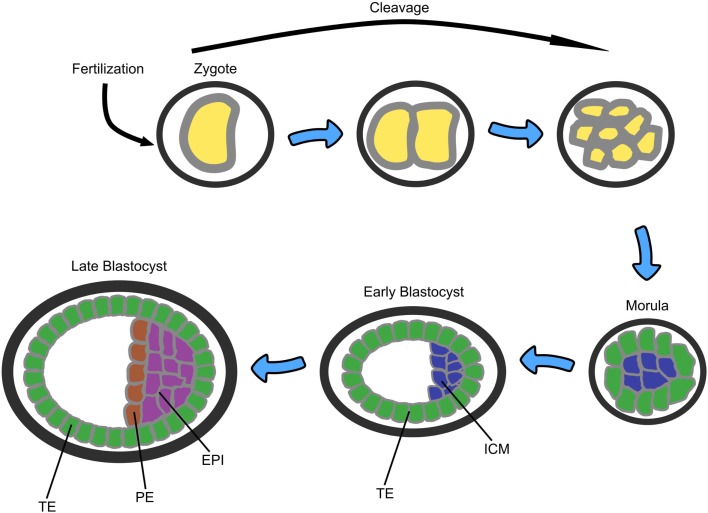
A sketch of the early stages of mammalian embryonic development starting from zygote, through morula (8–16 cells), to blastocyst (32–64 cells). TE, trophectoderm; ICM, inner cell mass; PE, primitive endoderm; EPI, epiblast (53).